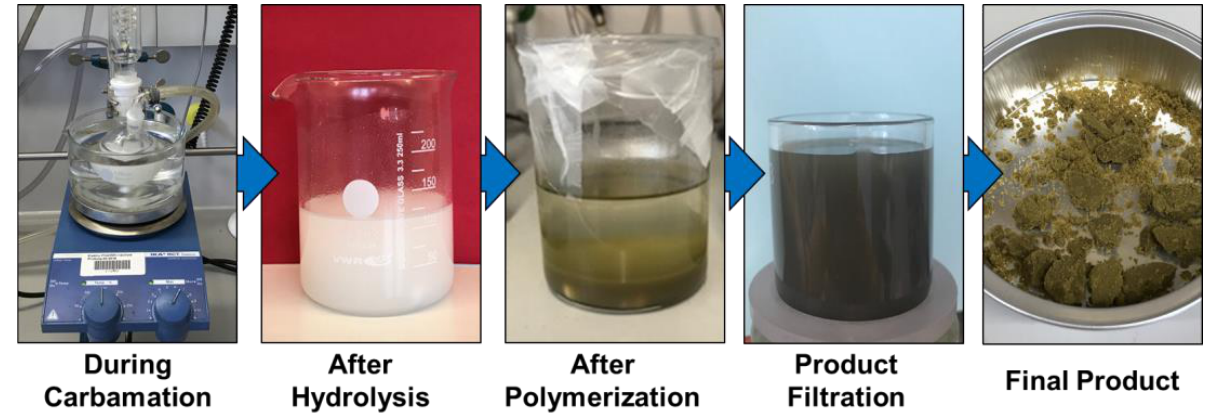
Figure 4. The change in CNCs ’ color after carbamation, hydrolysis, polymerization, and filtration. The elemental composition of the CNCs and the mass yield at each process stage were used to monitor the chemical changes on the CNC surface (Table 1). The original CNCs expectedly consisted mostly of carbon and oxygen atoms since hydrogen cannot be